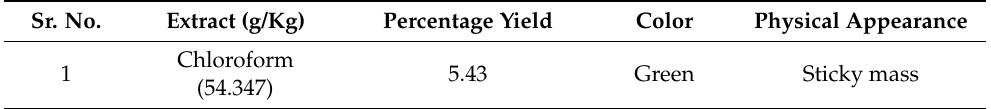
Table 1. Yield of extracts of E. microphylla . Sr.